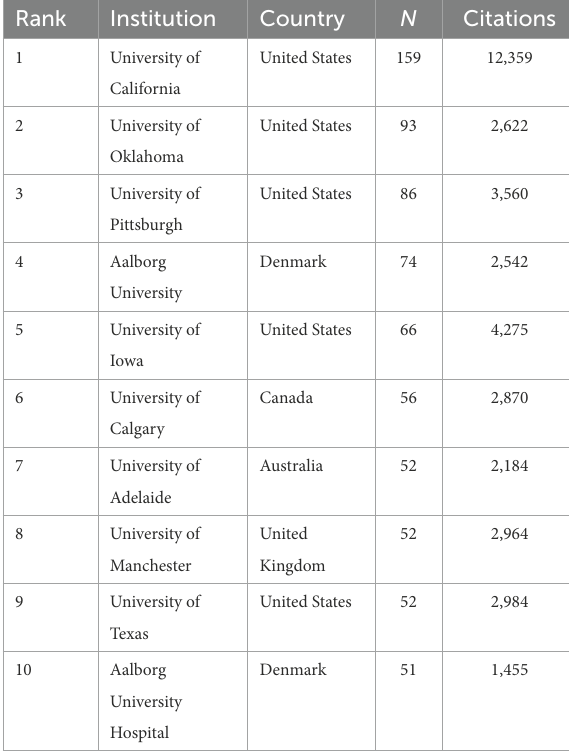
TABLE 3 The top 10 productive